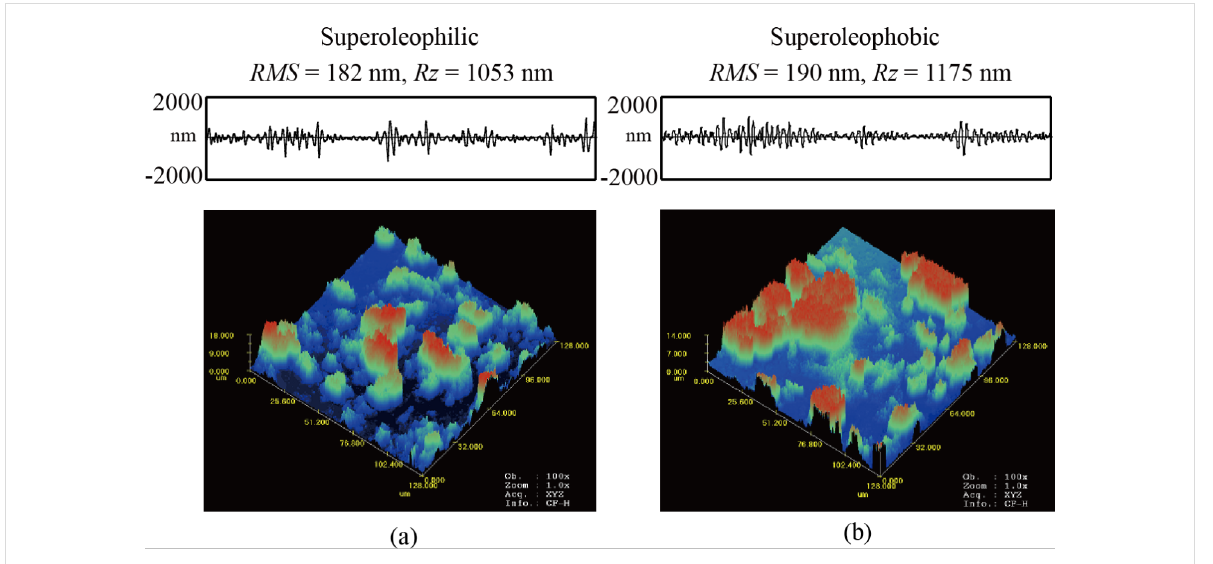
Figure 5: Confocal laser scanning images in the air, and measured values of RMS and R z roughness of (a) superoleophilic sample a1 and (b) super- oleophobic sample b1 at 128 μ m × 128 μ m scan size.